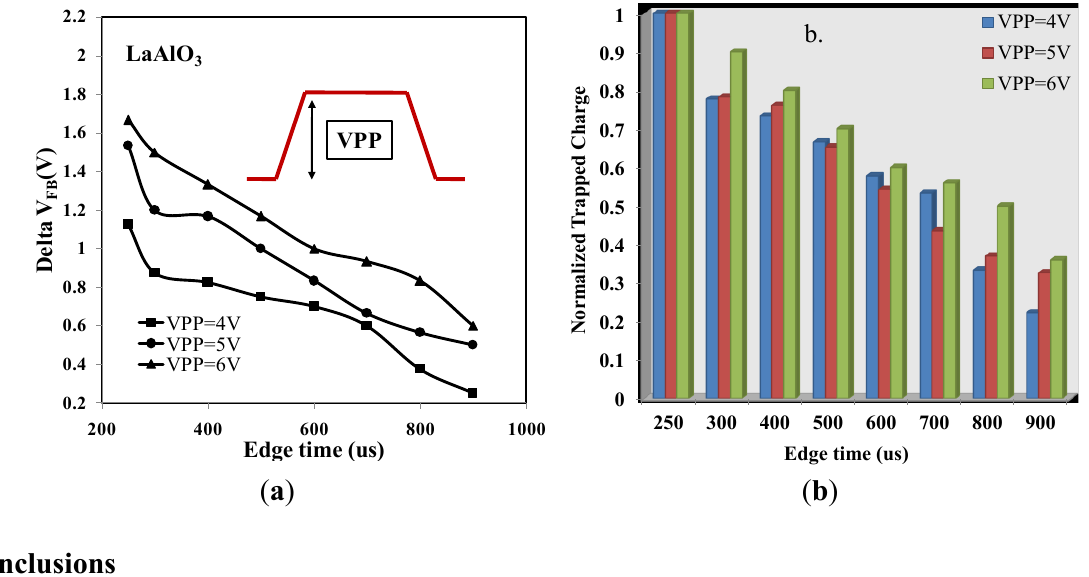
Figure 8. ( a ) Variation of Flat-band Voltage (V) with Different Edging Time (μs) of The LaAlO 3 , Samples under different VPP level. VPP denotes peak to peak voltage of the pulse. ( b ) Normalized Trapped Charge with Different Edging Time